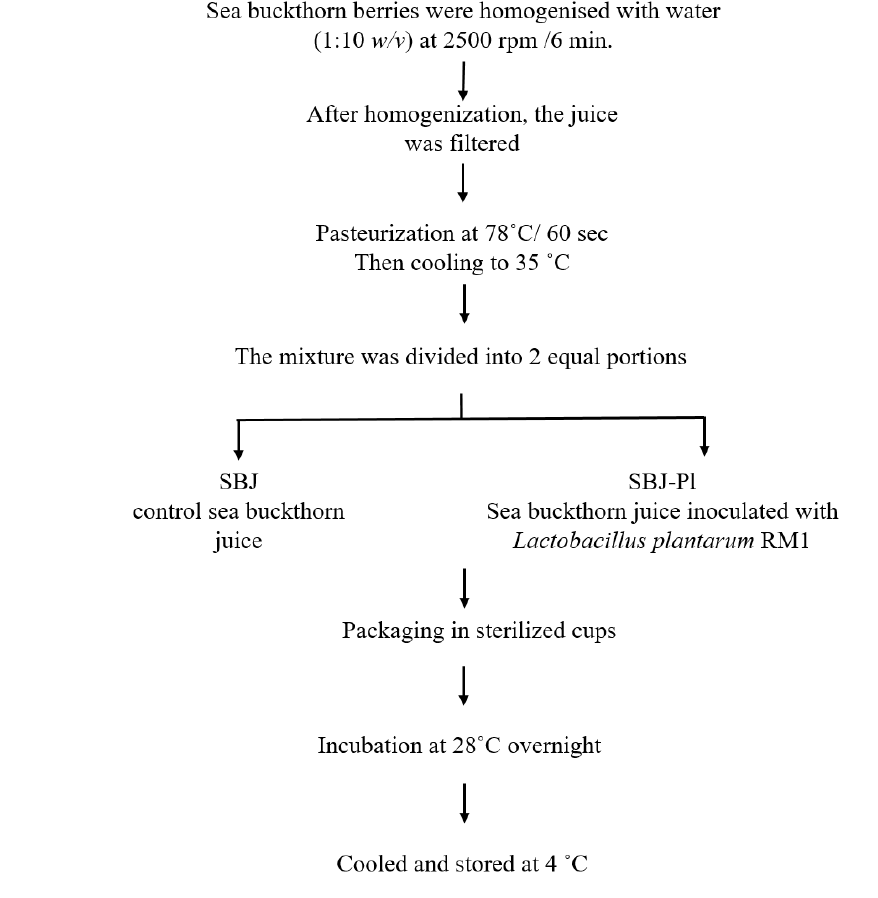
Figure 1. Manufacture steps of fermented sea buckthorn juice with Lactobacillus plantarum RM1.